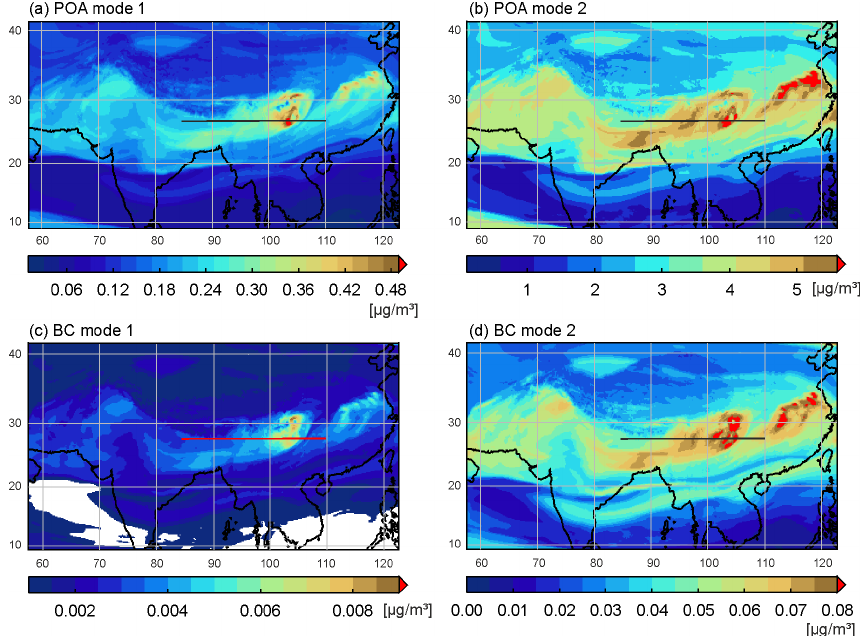
Figure 10. Horizontal map of (a) POA of mode #1, (b) POA of mode #2, (c) BC of mode #1, and (d) BC of mode #2 at the altitude of 14.8km at 18:00UTC on 7 August. The location of vertical cross sections used in Fig. 11 is marked by a black (or red for visibility) solid line in each